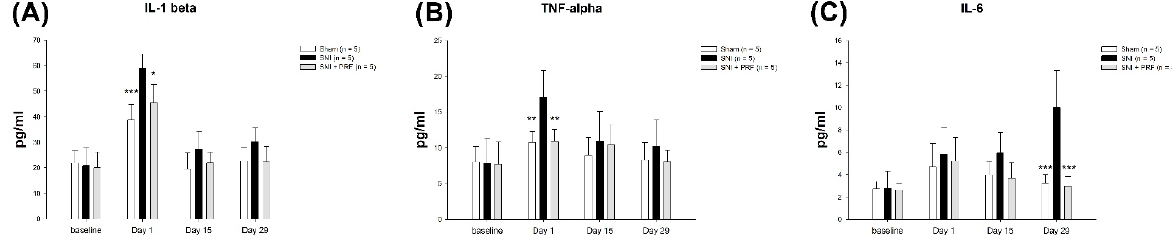
Figure 5. Expression of proinflammatory cytokines in serum at baseline, day 1, day 15, and day 29. The levels of (A) IL-1 β , (B) TNF- α , and (C) IL-6 in serum of sham operation, SNI without PRF, and SNI plus PRF rats. Data are expressed as the mean ± SD. *p < 0.05 compared to the SNI group, **p < 0.01 compared to the SNI group, ***p < 0.001 compared to the SNI group. n = 5 in each group.